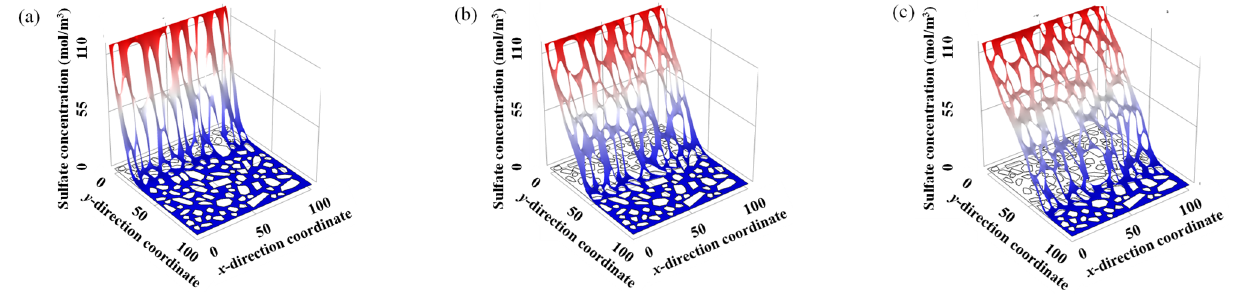
Figure 9. Spatial distribution of sulfate ion concentration at three different ingress time. ( a ) 1st year, ( b ) 5th year, and ( c ) 10th year, respectively.